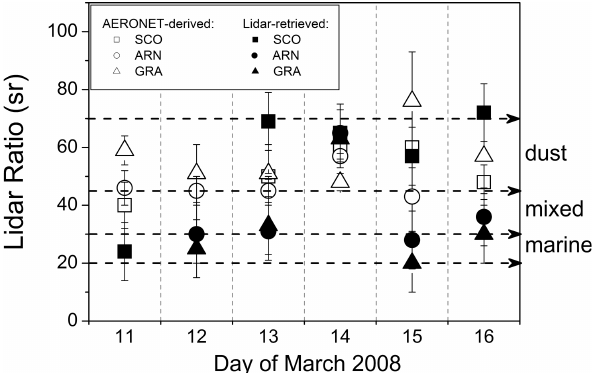
Fig. 9. Lidar-retrieved LR (extinction-to-backscatter ratio) values together with those columnar-integrated AERONET-derived ones (see Table 2). LR ranges as adopted for aerosol-type discrimination are also marked (shaded